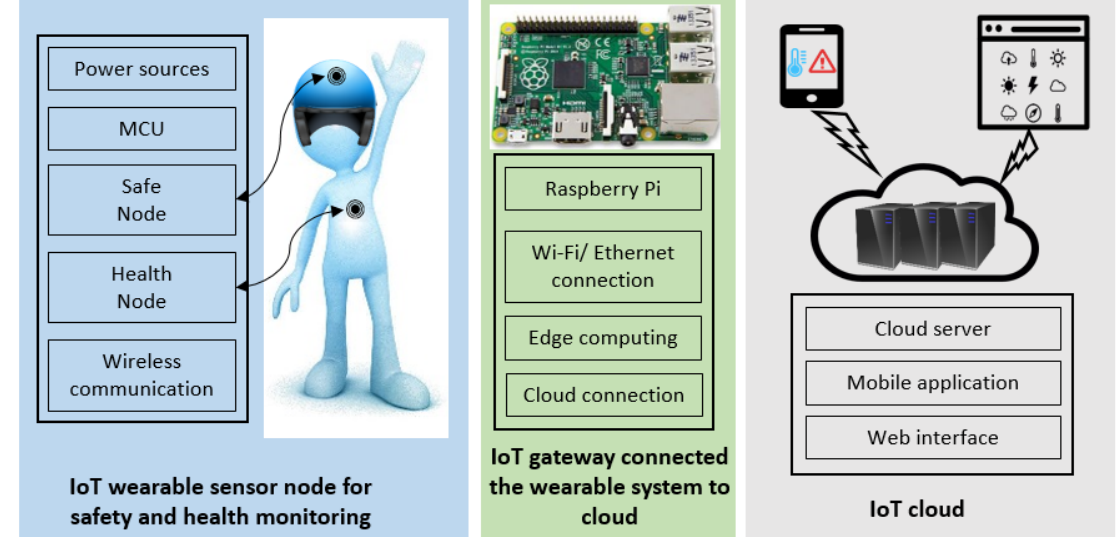
Figure 1. System architecture of the wearable sensor network for environmental and health